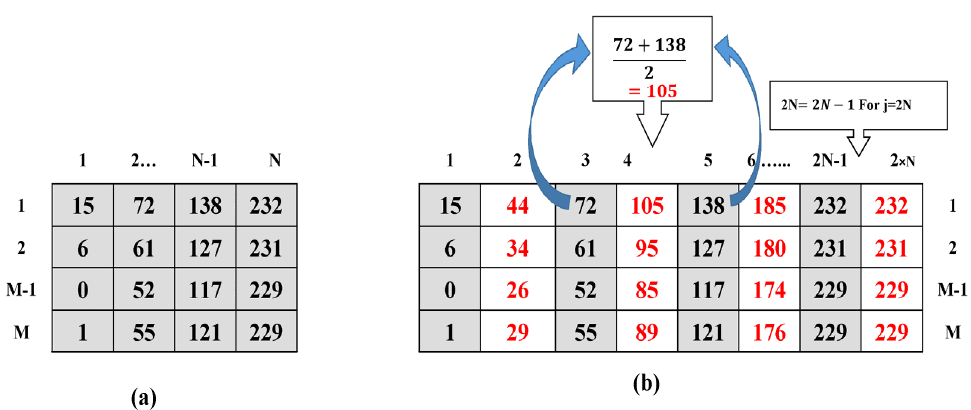
Figure 3. ( a ) Original image block; ( b ) Generation of the cover image using ODNMI.